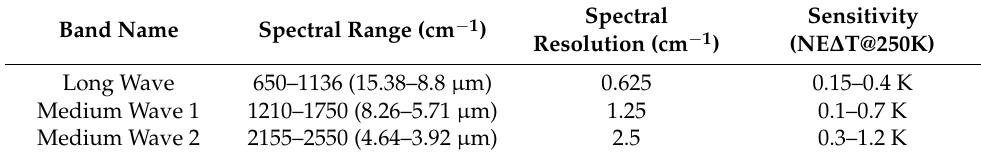
Table 1. Spectral characteristic of Fengyun-3D/HIRAS